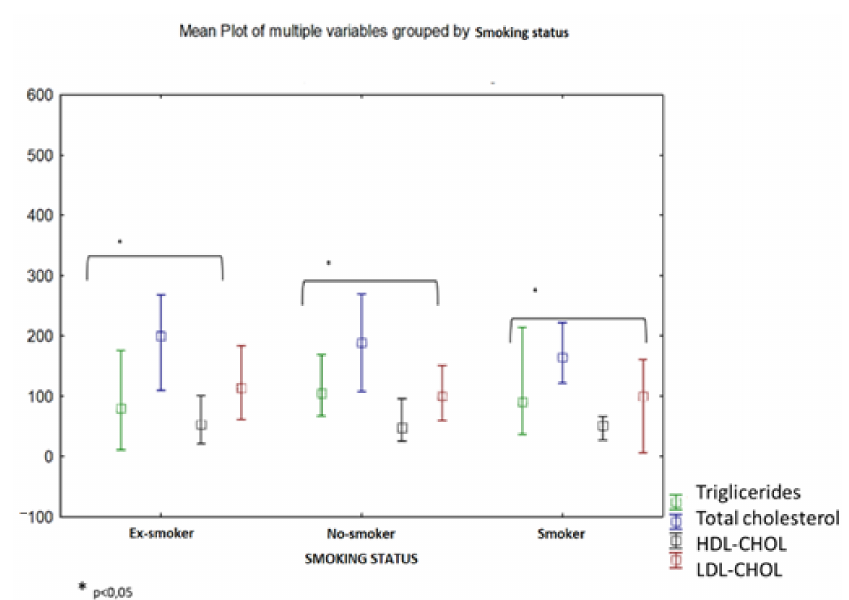
Figure 4. Lipidic profile (triglycerides, total cholesterol, HDL-CHOL, LDL-CHOL) in blood serum of COPD patients depending on the smoking status (smokers/non-smokers/ex-smokers). In Table 4, the lipid profile of the investigated patients was evaluated depending also on the demographic area and comorbidities shown in Table 1. The statistical results evaluated with the Mann–Whitney U test for urban/rural area differentiation pointed out that there are no statistically significant differences ( p > 0.05) in the assessment of the demographic area of the patients included in the present study. The level of serum lipids was evaluated according to comorbidities; the statistical results showed that there were no statistically significant differences, with the exception of obesity ( p =